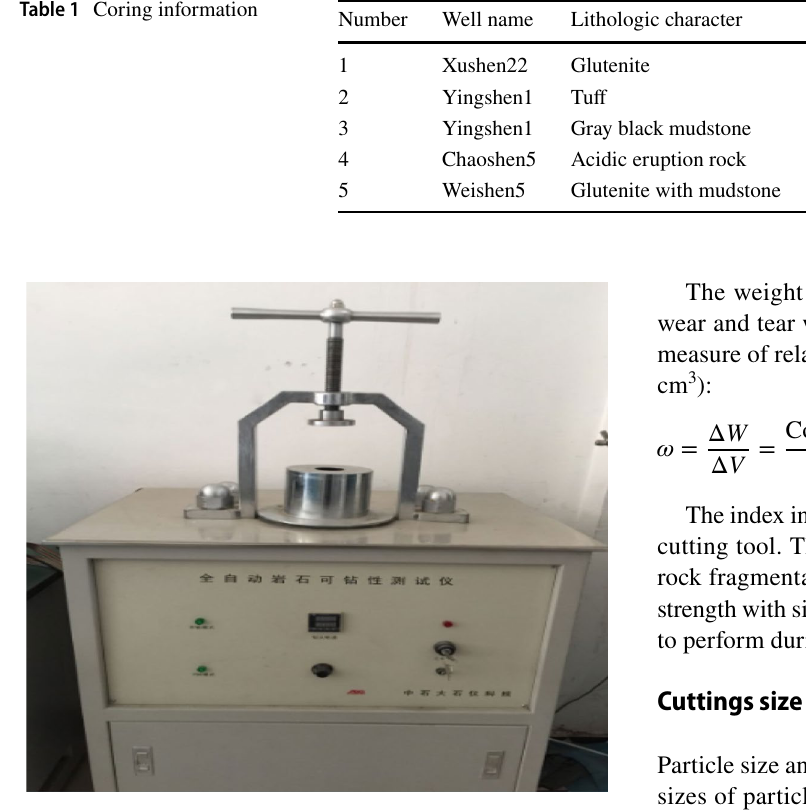
Fig. 1 Fully automatic rock drilling test instrument